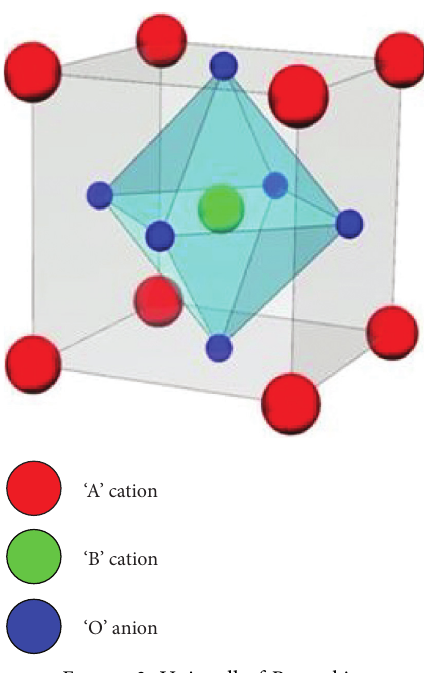
Figure 3: Unit cell of